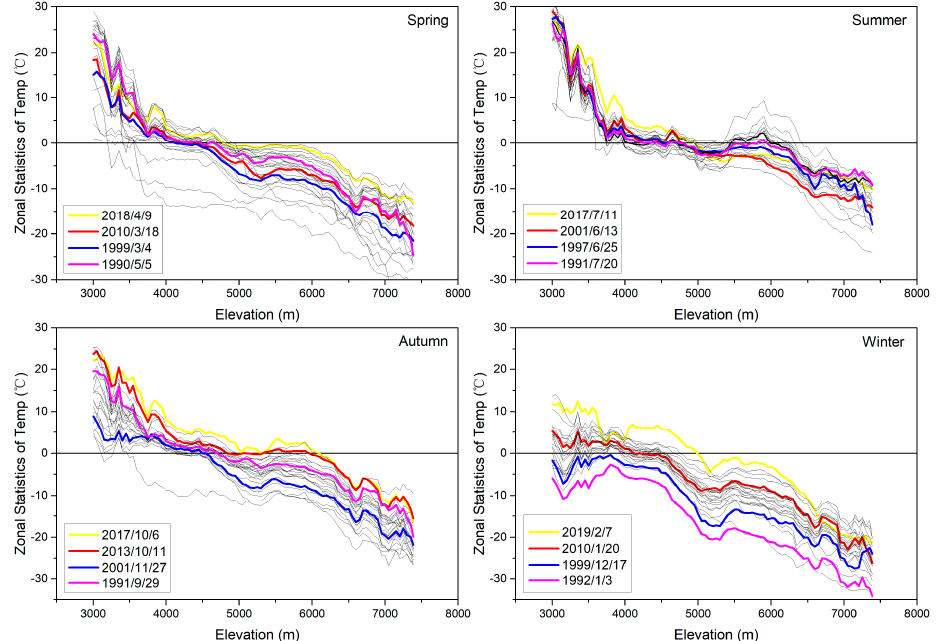
Figure 4. Spatial patterns of surface temperatures on the Hailuogou glacier for the different seasons and sensor types (9 December 2017; 13 October 2008; 25 June 1997; 5 May 1990).